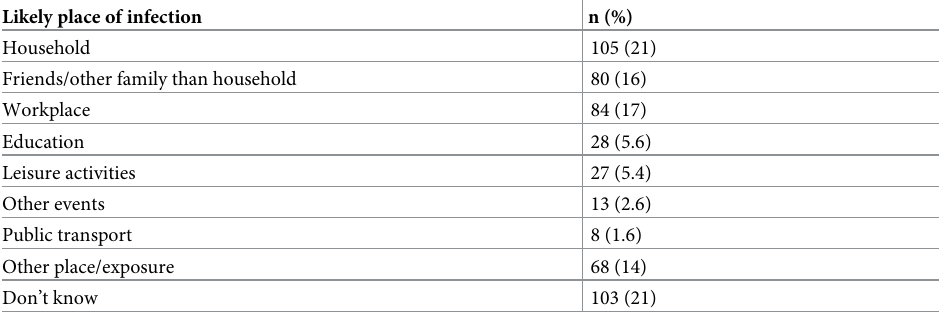
Table 2. Number and proportion of likely place of infection as indicated by cases (n = 500) 1 . Likely place of infection